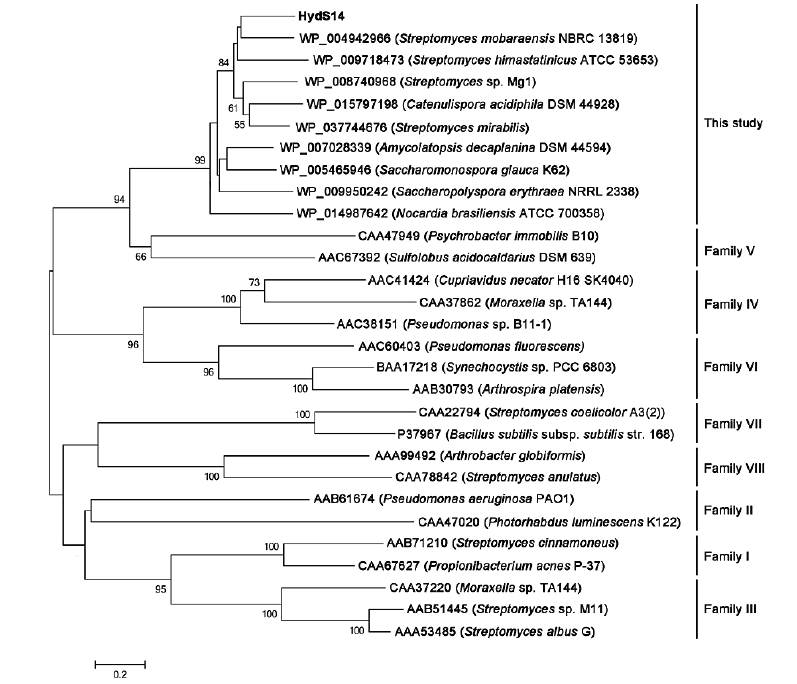
Figure 3. Phylogenetic tree of HydS14 and other esterases/lipase families. The phylogenetic tree was constructed using the neighbor-joining method with the MEGA software, version 4.1. The numbers associated with the branches refer to the bootstrap values resulting from 1000 replicate resamplings; only bootstrap values higher than 50% are shown. The scale represents the number of amino acid substitutions per site. The HydS14 is shown in